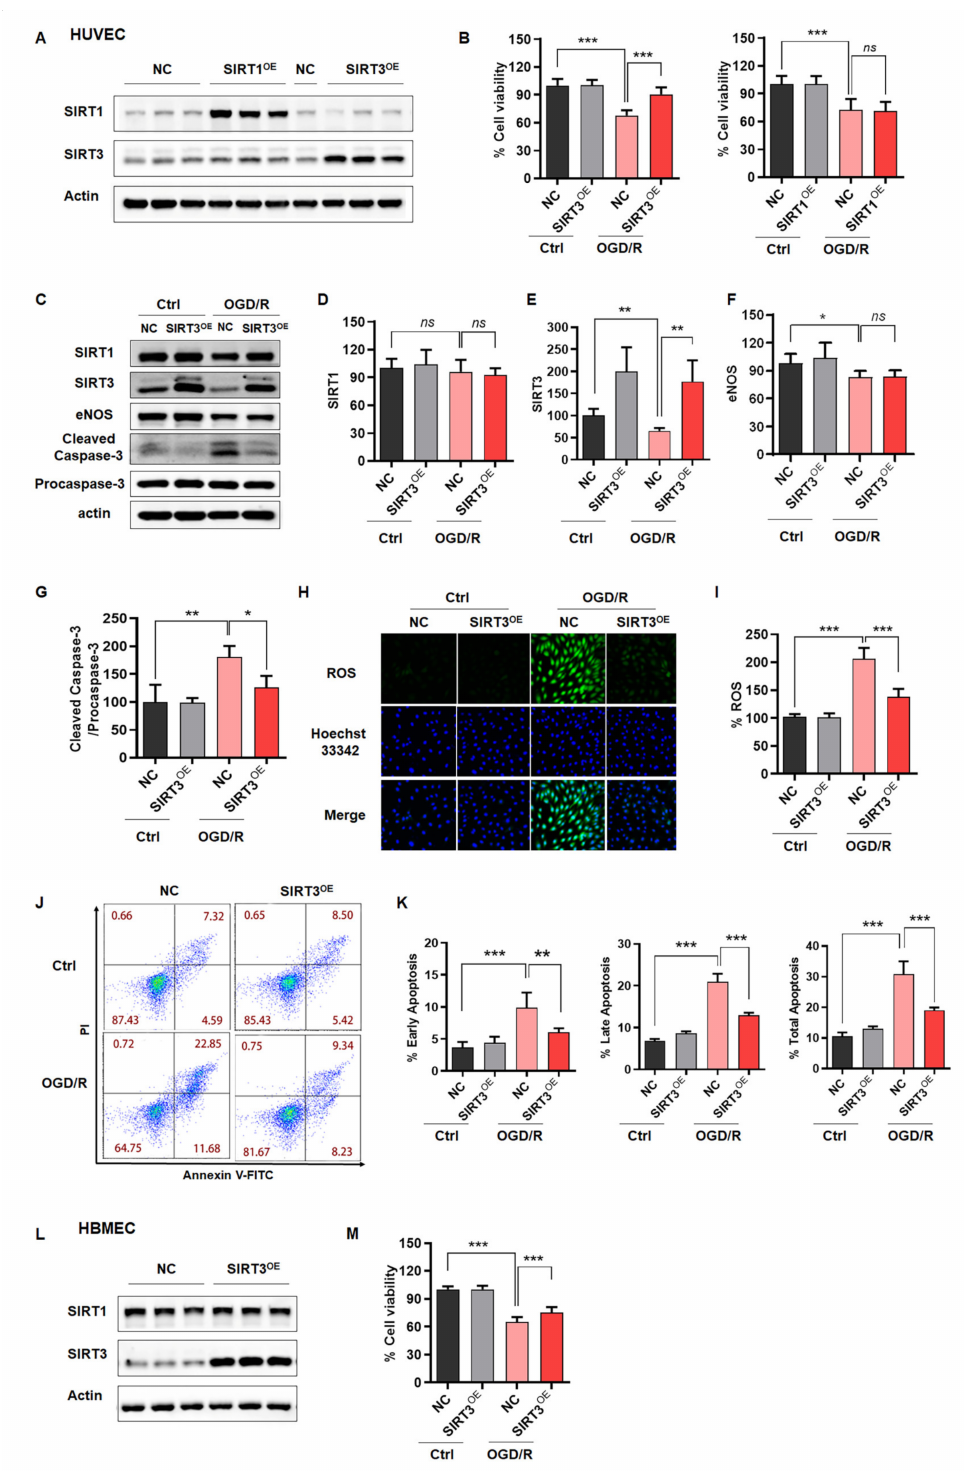
Figure 3. Rescue of SIRT3 expression reverses OGD/R-induced cell damage in ECs. ( A ) Western blotting verified SIRT3 and SIRT1 expression in HUVECs infected with lentivirus of SIRT3, SIRT1 or vector. ( B ) CTG assay assessed the cell viability of NC, SIRT3 OE or SIRT1 OE HUVECs under normal or OGD/R-treated conditions. ( C – G ) Representative immunoblot and statistical analysis of SIRT1, SIRT3, eNOS, cleaved caspase-3 and procaspase-3 from whole-cell lysates of NC or SIRT3 OE HUVECs under normal or OGD/R-treated conditions. ( H , I ) ROS levels in NC or SIRT3 OE HUVECs under normal or OGD/R-treated conditions. ( J , K ) FCM analysis showed endothelial apoptosis in NC